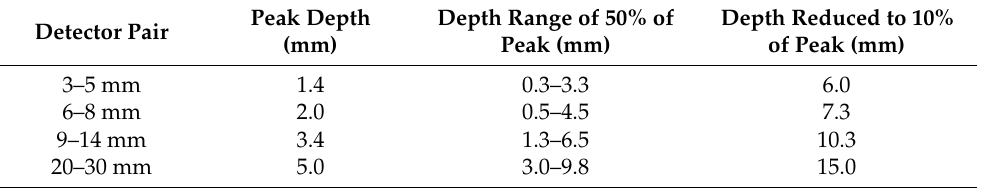
Figure 3. The relationship between measurement sensitivity and measurement depth in the four pairs of two detectors. Table 2. The depth where the sensitivity is maximum, the range of the depth where the sensitivity halves the maximum, and the depth where the sensitivity is 10% of the maximum obtained in the curves of the measurement sensitivity and measurement depth of the four pairs.